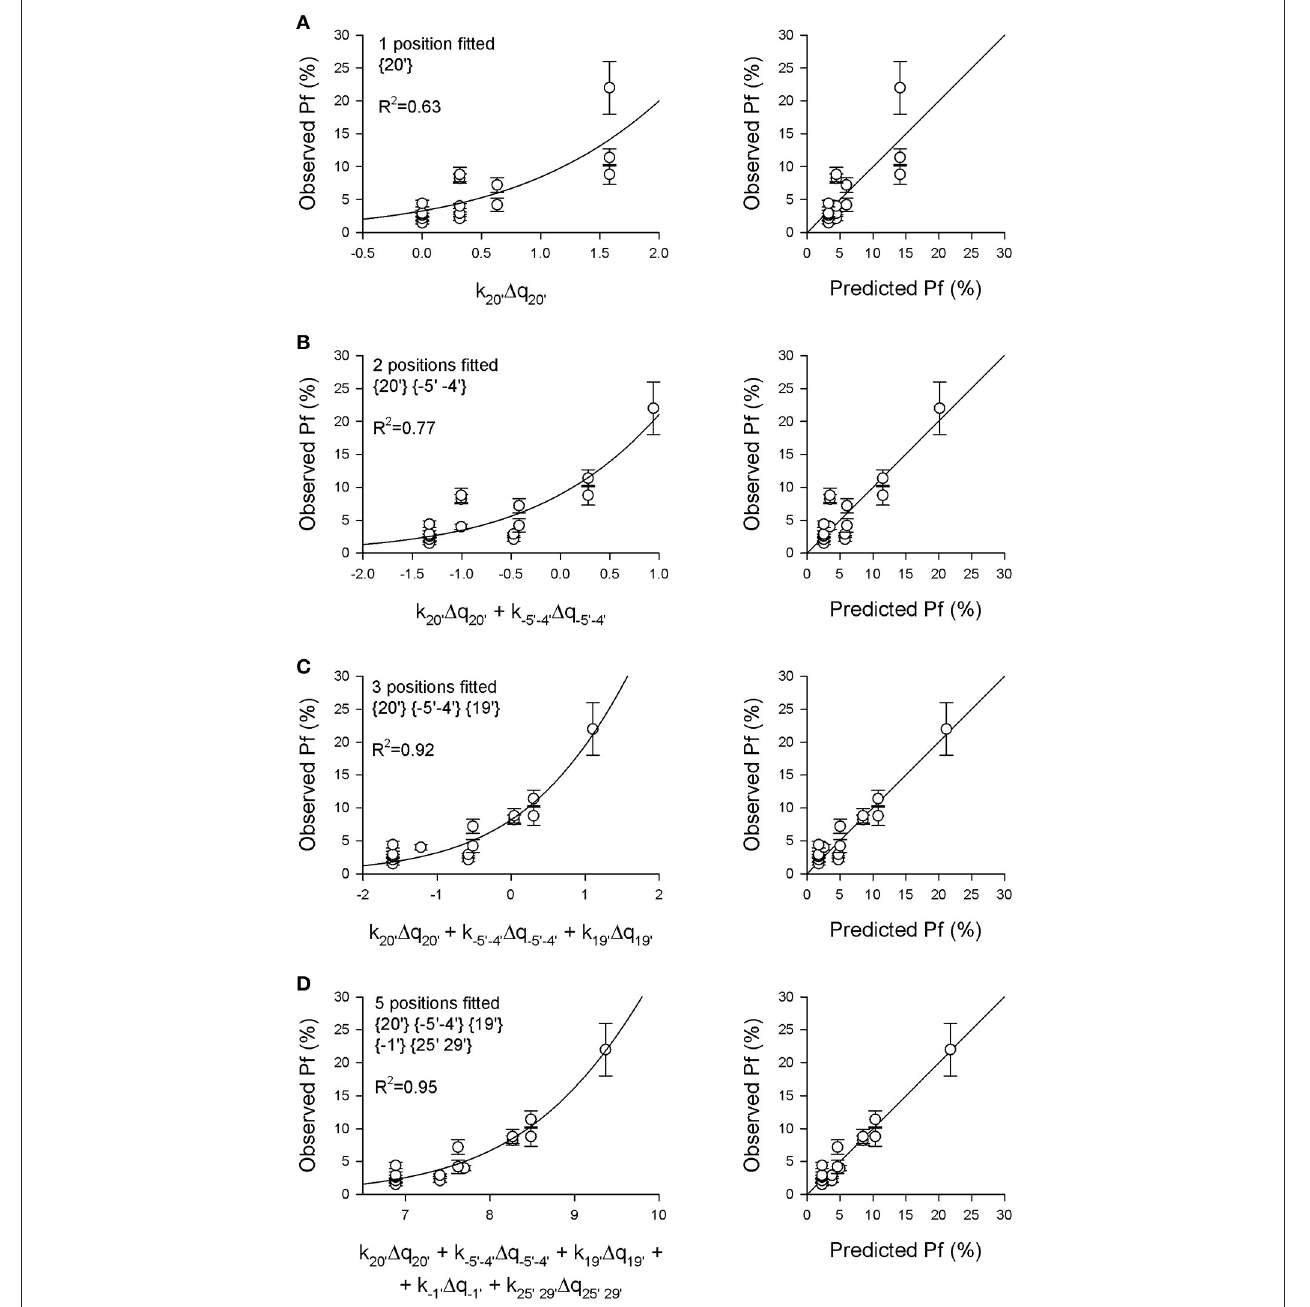
FIGURE 2 | The Pf -values of 16 different nAChRs are predicted by a model based on the charge distributions in five distinct pore regions. The experimentally measured Pf -values reported in Table 2 were plotted against the weighted sum of the electrical charges 1 q i present in different pore regions, as indicated, with the multiplicative k i -values allowed to vary in order to best fit the data, according to Equation P f = 1 (see Section Methods for 1 + const e P n i = 1 k i △ q i details). (A) Best fit of Pf -values (left) and comparison between observed and predicted Pf -values (right), using as independent variable only the electrical charge present in the extracellular position {20 ′ }, representing the main determinant of Ca 2 + permeability (const = 29.5, p = 0.0029; k 20 ′ = − 0.316, p = 0.0003). (B) The charge distributions in position {20 ′ } and in the intracellular position { − 5 ′ − 4 ′ } were used as independent variables (const = 10.2, p = 0.0501; k 20 ′ = − 0.321, p = 0.0001; k − 5 ′ − 4 ′ = 0.266, p = 0.013). (C) The charge distributions in positions {20 ′ }, { − 5 ′ − 4 ′ } and {19 ′ } were used as variables (const = 11.2, p = 0.0084; k 20 ′ = − 0.3806, p < 0.0001; k − 5 ′ − 4 ′ = 0.3197, p = 0.0002; k 19 ′ = − 1.260, p = 0.0002). Note the substantial improvement of the fit adding the charges in position {19 ′ } to the analysis, which now takes into account the negative glutamate residue present in α 5 subunits in this position. (D) The electrical charges of the five indicated positions were used as variables (const = 41917, p = 0.82; k 20 ′ = − 0.5654, p = 0.0134; k − 5 ′ − 4 ′ = 0.3521, p < 0.0001; k 19 ′ = − 0.0798, p = 0.90; k − 1 ′ = − 1,975, p = 0.0816; k 25 ′ 29 ′ = 0.491, p = 0.1598). Note the high R 2 -value and the excellent agreement between observed and predicted Pf -values.